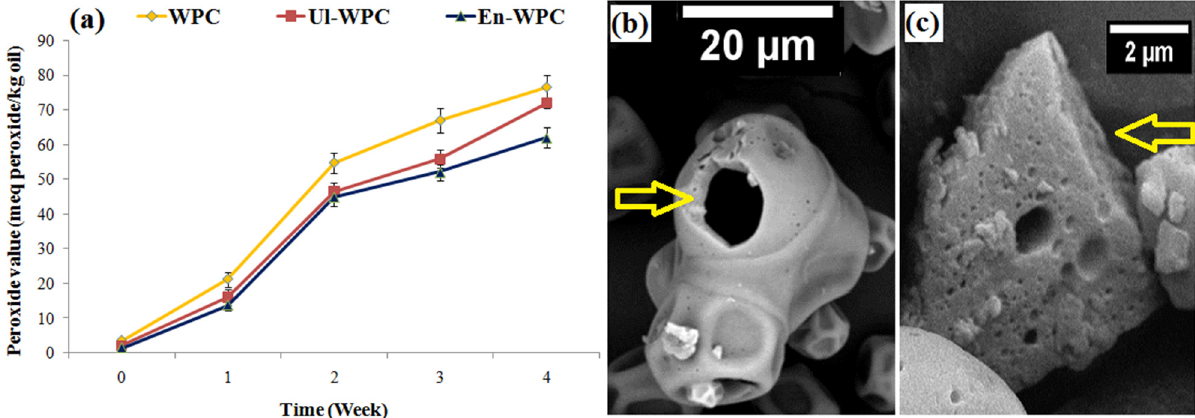
Figure 6. Peroxide value vs. storage time plot ( a ) and SEM images ( b , c ) of spray-dried grape seed oil emulsions prepared with intact WPC and WPC modified by enzymolysis for 30 min